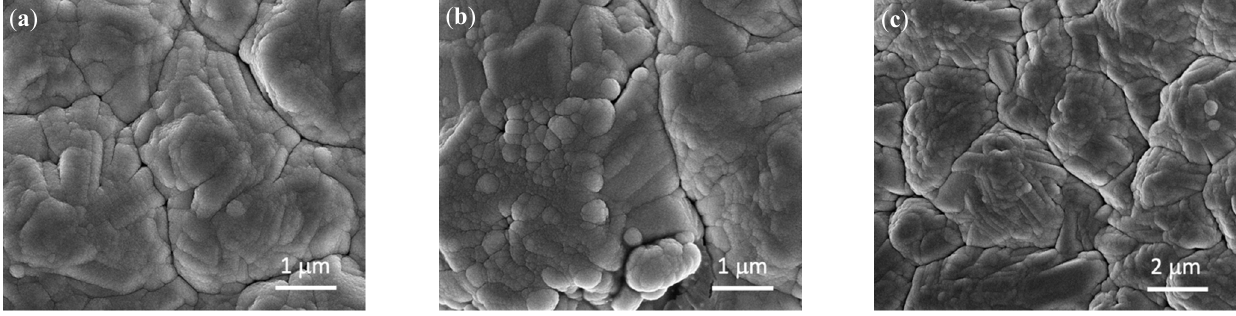
( c ) Figure 5. EDX analysis of ( a ) Si@Cu, ( b ) Si 3 N 4 @Cu, and ( c ) Si 3 N 4 @Si@Cu films. Transmission electron microscopy (TEM) was conducted to provide further infor- mation on the morphology of the as-prepared Si-based films beyond the surface. The first micrograph (Figure 6a) presents a network of amorphous silicon film, as opposed to the smooth structure in Figure 6b and the disconnected structure in Figure 6c. Evidently, the Si 3 N 4 @Si@Cu film has numerous spherical particles that are not present in the other Si- based films, as can be seen in Figure 6c. This micrograph shows a homogeneous layer of amorphous silicon with a silicon nitride layer.